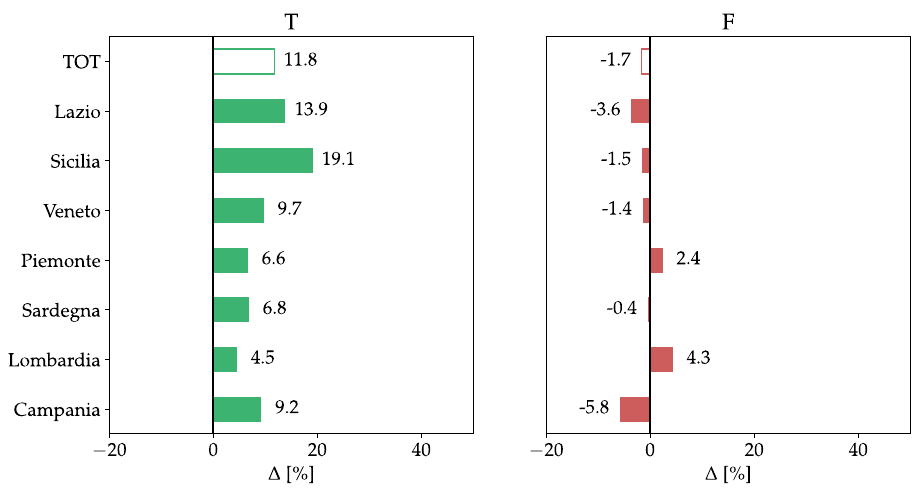
Figure 23. Percentage difference comparison between new and current criteria: CN Subset.